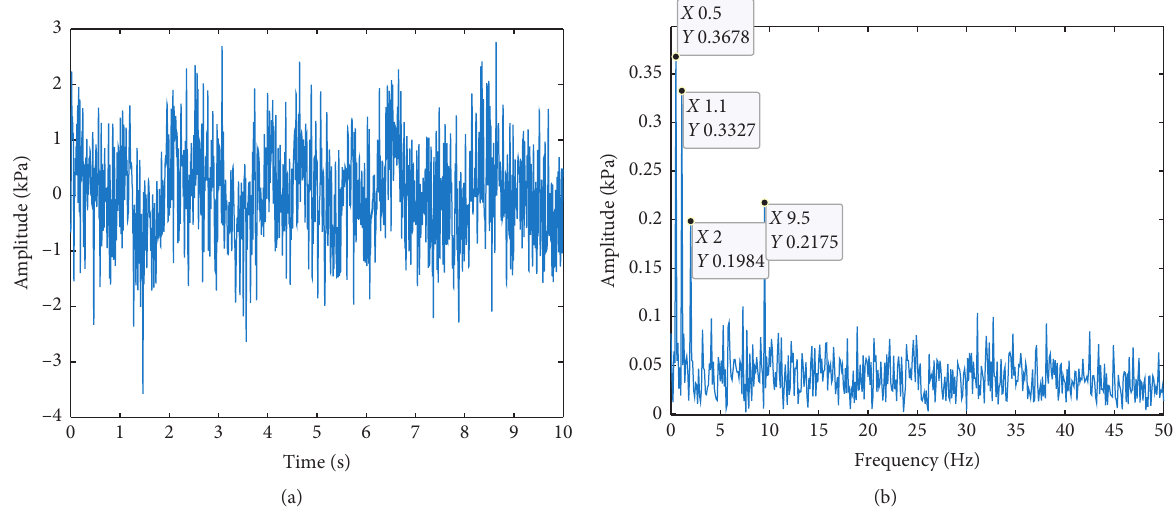
Figure 5: Waveform and spectrum diagram after EMD noise reduction. (a) Waveform diagram. (b)